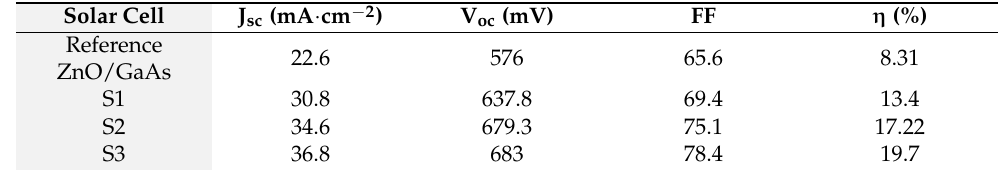
Table 3. Photovoltaic parameters for the investigated heterojunction solar cells: (S 1 ) represents a heterojunction that is fabricated using GaAs gettered substrate (VTP2) and an optimized ZnO emitter thickness (391 nm), with a flat interface state. Microgrooves at the interface were added in (S 2 ). In sample (S 3 ), both the microgrooves at the interfaces and ZnO nanorods at the front surface of the ZnO emitter were